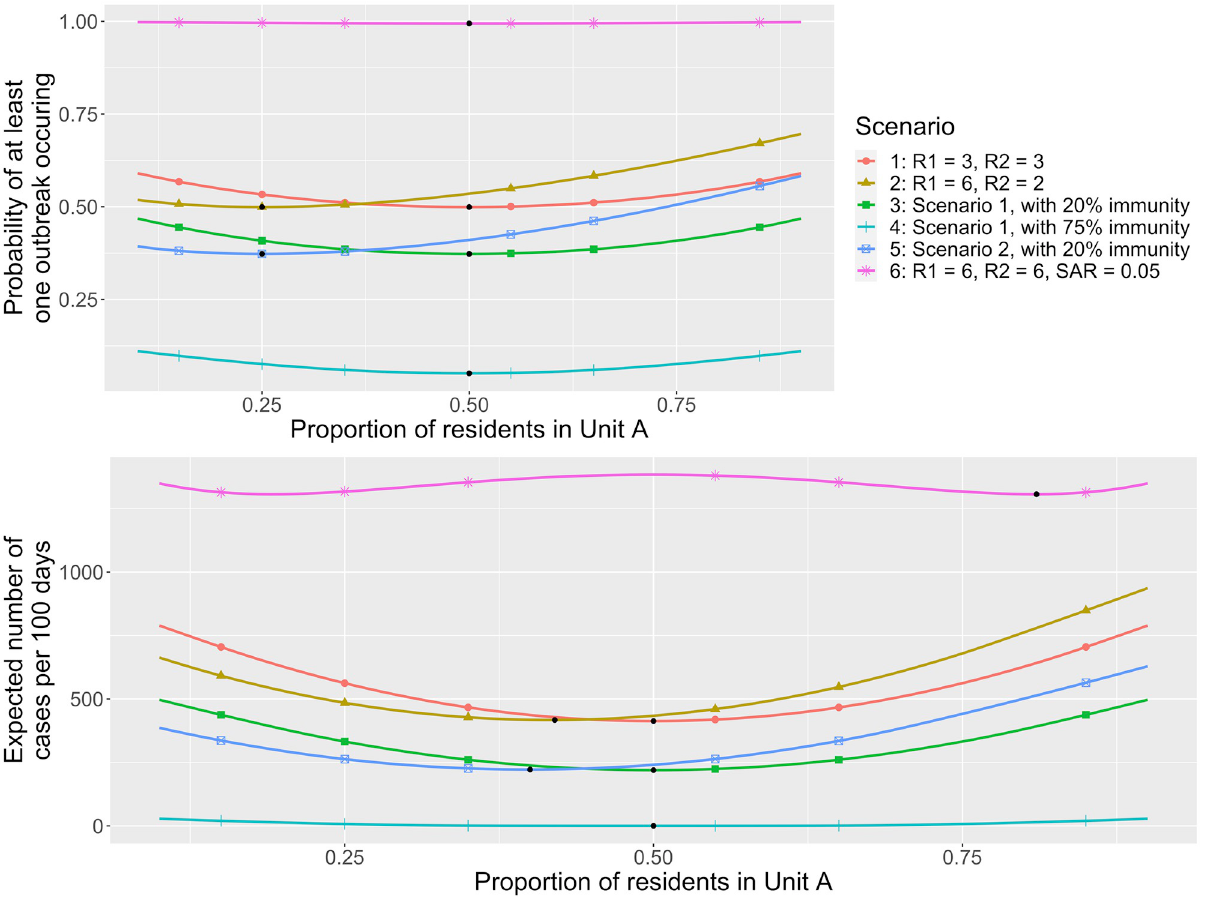
Fig 5. Optimal distribution of residents between two independent residential units. (Top) Probability that an outbreak occurs in at least one of two residential units within 100 days. We denote the residential units as ‘Unit A’ and ‘Unit B’. Results are shown as a proportion of the population that is housed in Unit A. Density-dependent control is assumed (i.e. Θ = Θ = 1). The total number of residents is assumed to be 2,000. Thus, if 20% of the N R population have immunity from control, a proportion of residents housed in Unit A of 0.25 corresponds to 400 susceptible residents in Unit A and 1,200 in Unit B. The colored lines represent six different scenarios as indicated by the legend. The black dots indicate the minimum possible probability. The reproduction values in the legend correspond to the reproduction number if the 2,000 residents are all susceptible and distributed equally in both residential units. In scenario 1 the transmission in the two residential units are identical. In scenario 2, Unit A has higher transmission than Unit B. Scenarios 3, 4 and 5, are identical to scenarios 1 or 2 except that a fraction of the residents in each residential unit have immunity from vaccination or prior infection. In scenario 6, which is designed to model a very risky housing environment, the probability that an infected staff member transmits infection to a resident ( α = 0.05) is increased five-fold compared to the other scenarios and the reproduction number for both residential units is high. ic (Bottom) The expected number of cases per 100 days for both residential units combined is shown as a function of the proportion of residents in Unit A. The black dots indicate the minimum possible expected number of cases. The bottom panel is otherwise analogous to the top panel. Except as noted above, the parameter values are identical to Fig 2.